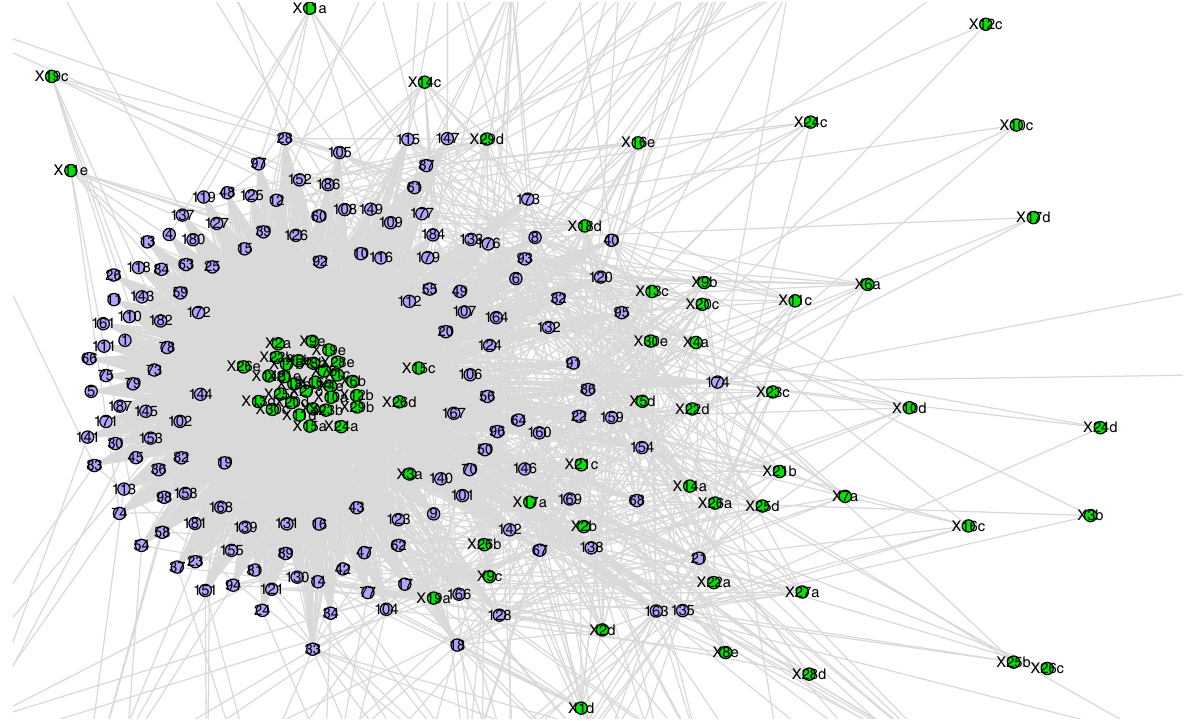
FIG. 2. Cut out of bipartite network showing students (purple) and response items (green). The normative response items form a central cluster in the middle. Two non-normative response items, 15c and 26d, are on the outskirts of this cluster. The eastern parts of the network seems to show more complex